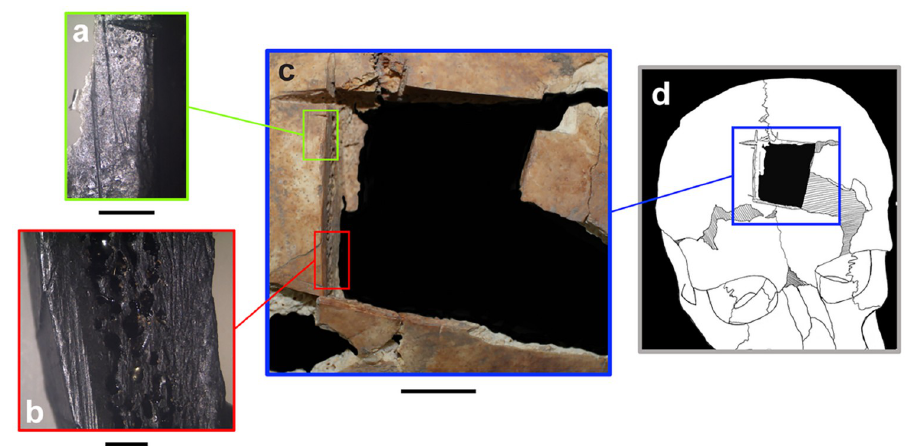
Fig 6. Trephination of Individual 1. a-b: Magnified edges of the trephination, each with a 2 mm scale bar. Images captured with a Leica EZ4D stereo microscope. c: All four edges of the trephination, scale bar is 1 cm. d: Reconstructed location of trephination on